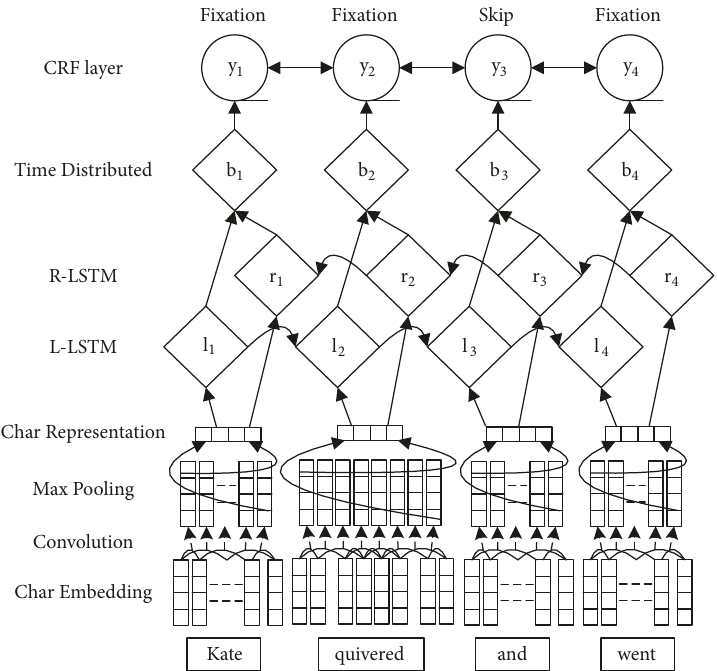
Figure 3: The CNN-LSTM-CRF architecture for predicting fixation in reading. The first layer is the embedding layer, which vectorizes the text corpus by converting each text into a sequence of integers. The second layer is the CNN layer, which extracts word form information from characters in a word and encoding it into a neural representation. The third layer is the bidirectional LSTM neural network, which can effectively use past (left) and future (right) contexts. The fourth layer is the CRF layer, which is used for sentence-level sequence labeling.